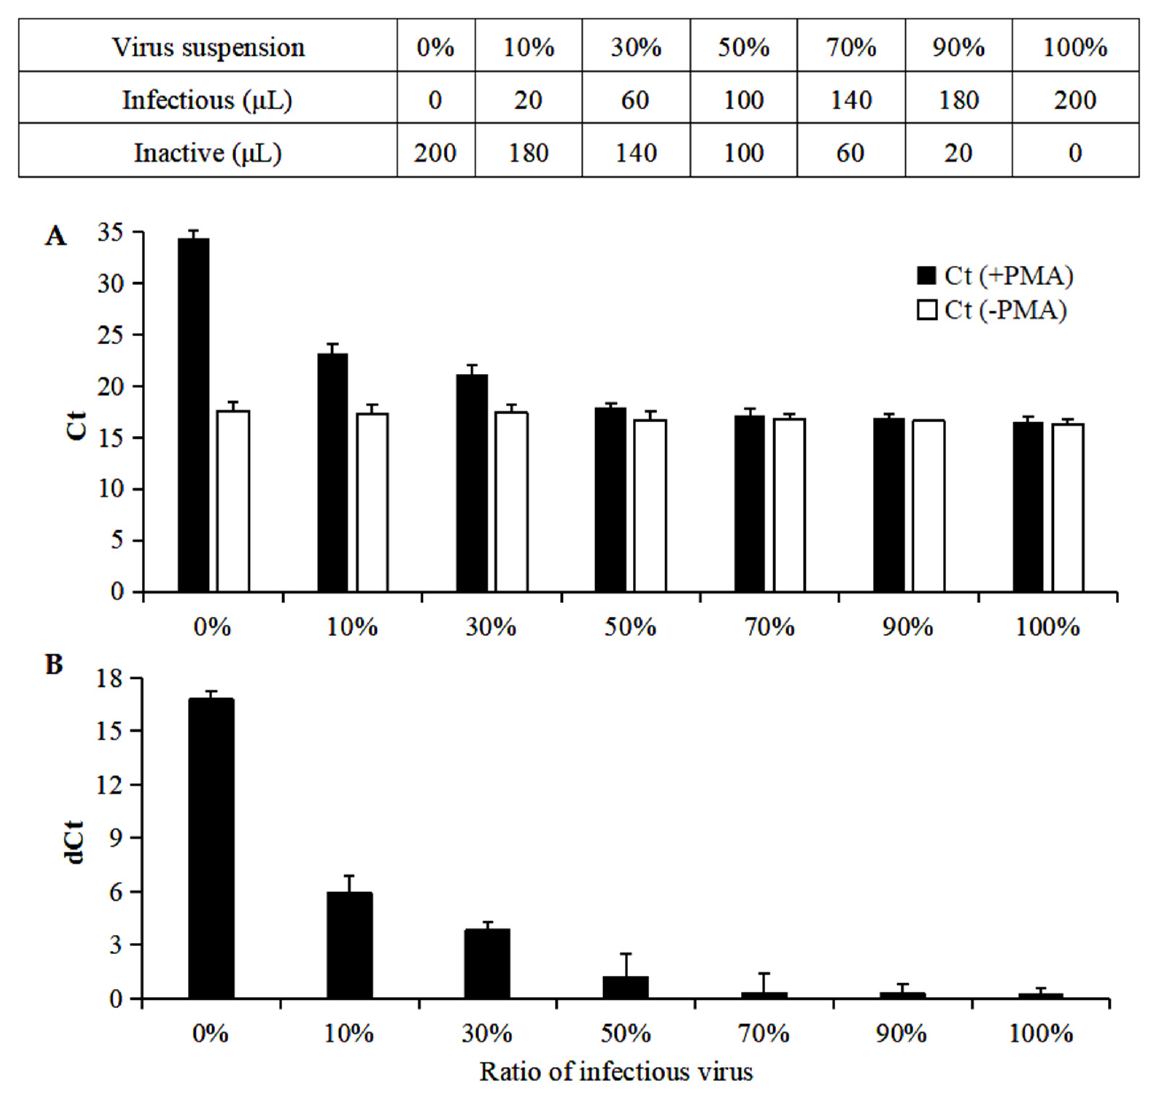
Figure 4. Effectiveness of PMA-assisted RT-qPCR in detecting infectious CGMMV from viral mixtures with defined ratios. Infectious and heat-inactivated CGMMV viruses were mixed in predefined ratios (0%, 10%, 30%, 50%, 70%, 90% and 100%), and the concentrations of total or infectious CGMMV viruses were determined by RT-qPCR and PMA-RT-qPCR assays. ( A ) Ct values and ( B ) dCt values were obtained by RT-qPCR and PMA-RT-qPCR assays. dCt = Ct (+PMA) − Ct ( − PMA).